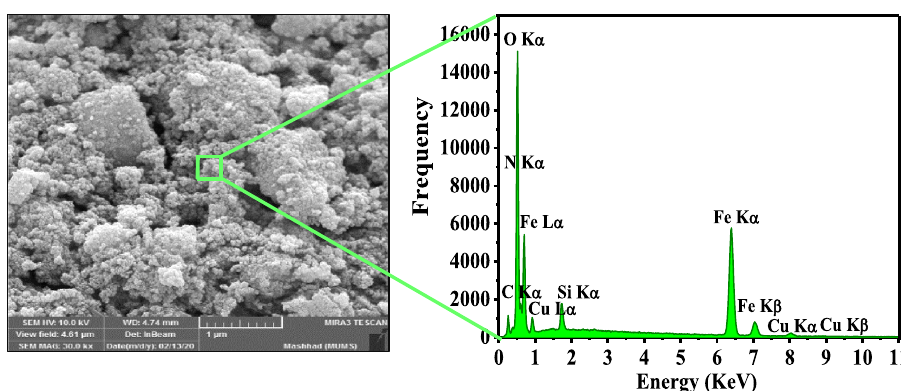
Figure 8. EDX analysis of the γ-Fe 2 O 3 @PEG@PAMAM G 0 -Cu catalyst.